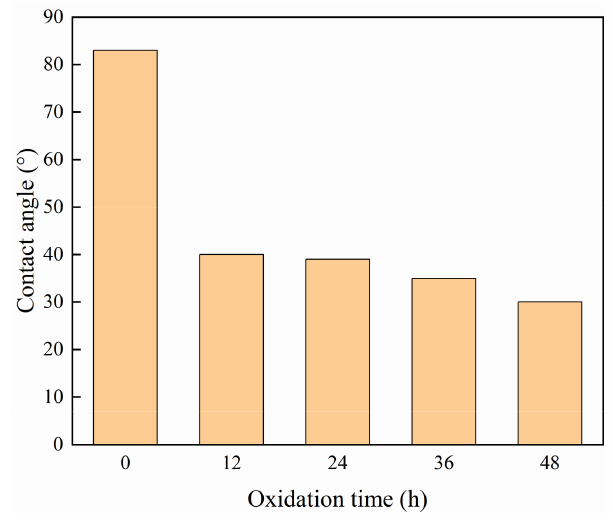
Figure 4. Contact angles of oxidized coals under different oxidization times.